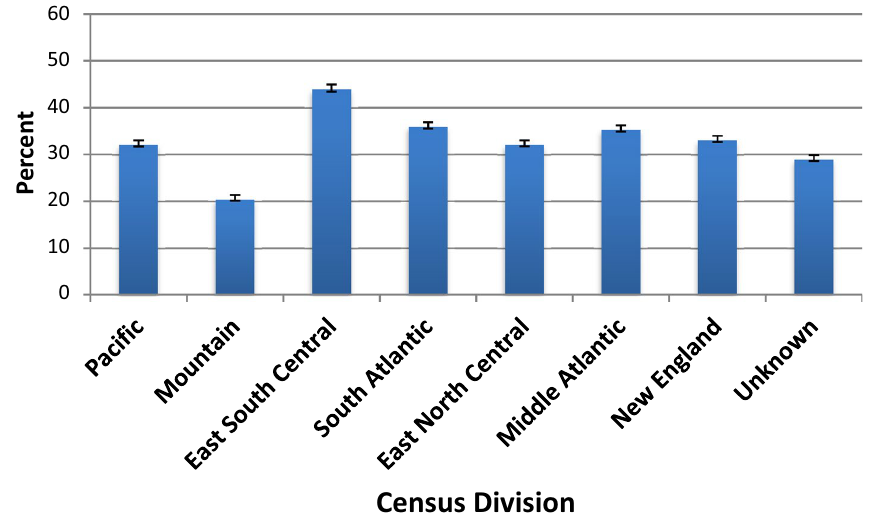
Figure 4. Crude HTN prevalence in All of Us by geographic region, 2018–2019. Error bars show 95% confidence intervals for HTN prevalence estimates. U.S. Census data is not available for age-distribution by geographic region. Figure was created with Microsoft Excel for Mac, Version